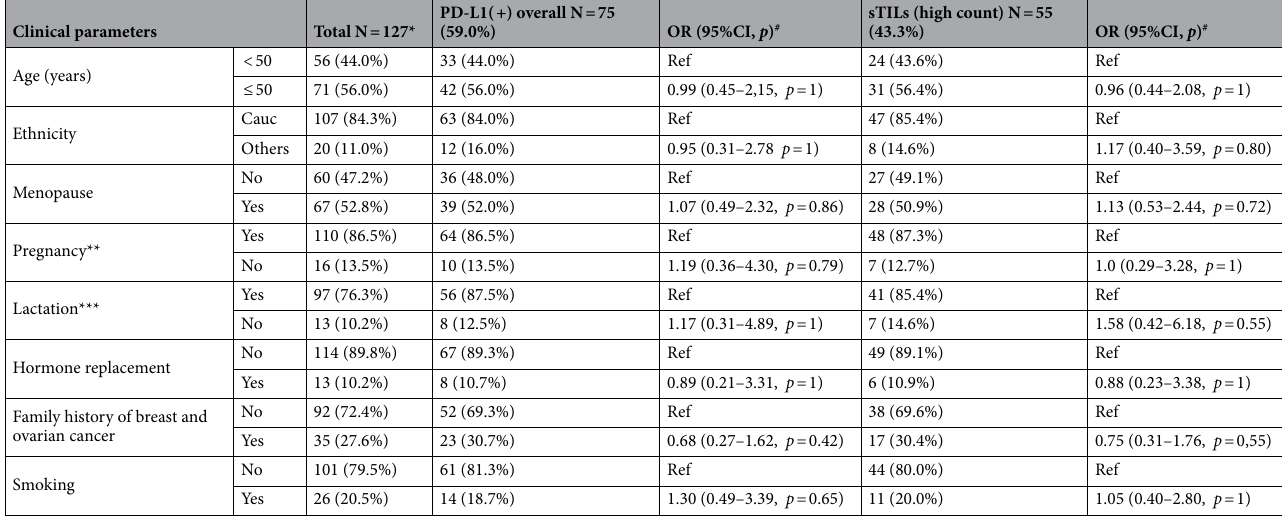
Table 1. Correlation between the overall PD-L1 expression and high sTIL counts in the diagnostic core needle biopsies and clinical parameters. Cauc Caucasian. *Three women had bilateral breast carcinoma, sTILs: stromal tumor infiltrating lymphocytes; Ref: reference value; missing information in one case; lactation was considered exclusively for patients who had a previous pregnancy. # p value calculation using Fisher’s exact